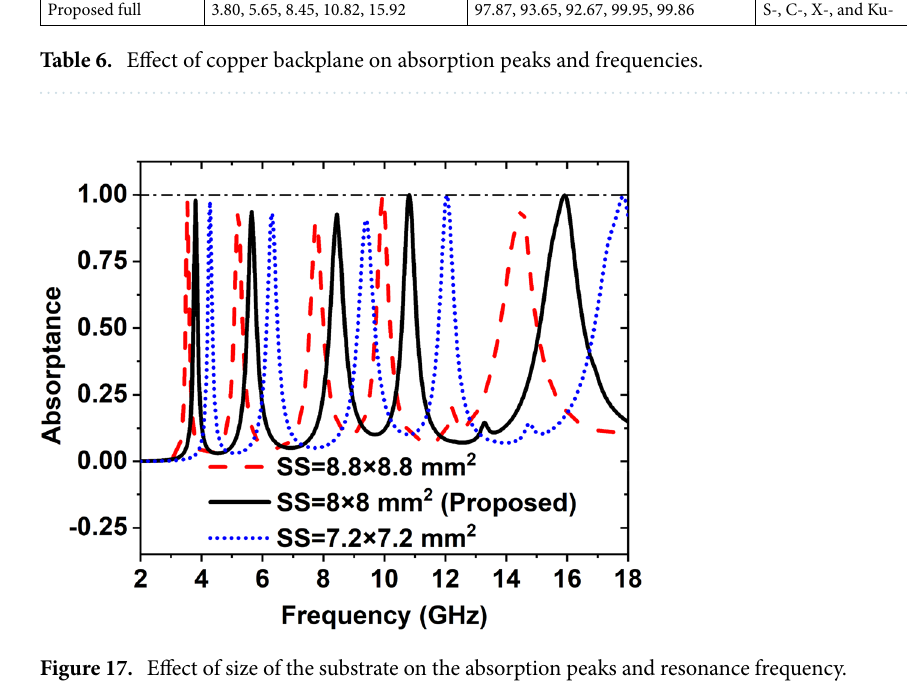
Substrate size (mm 2